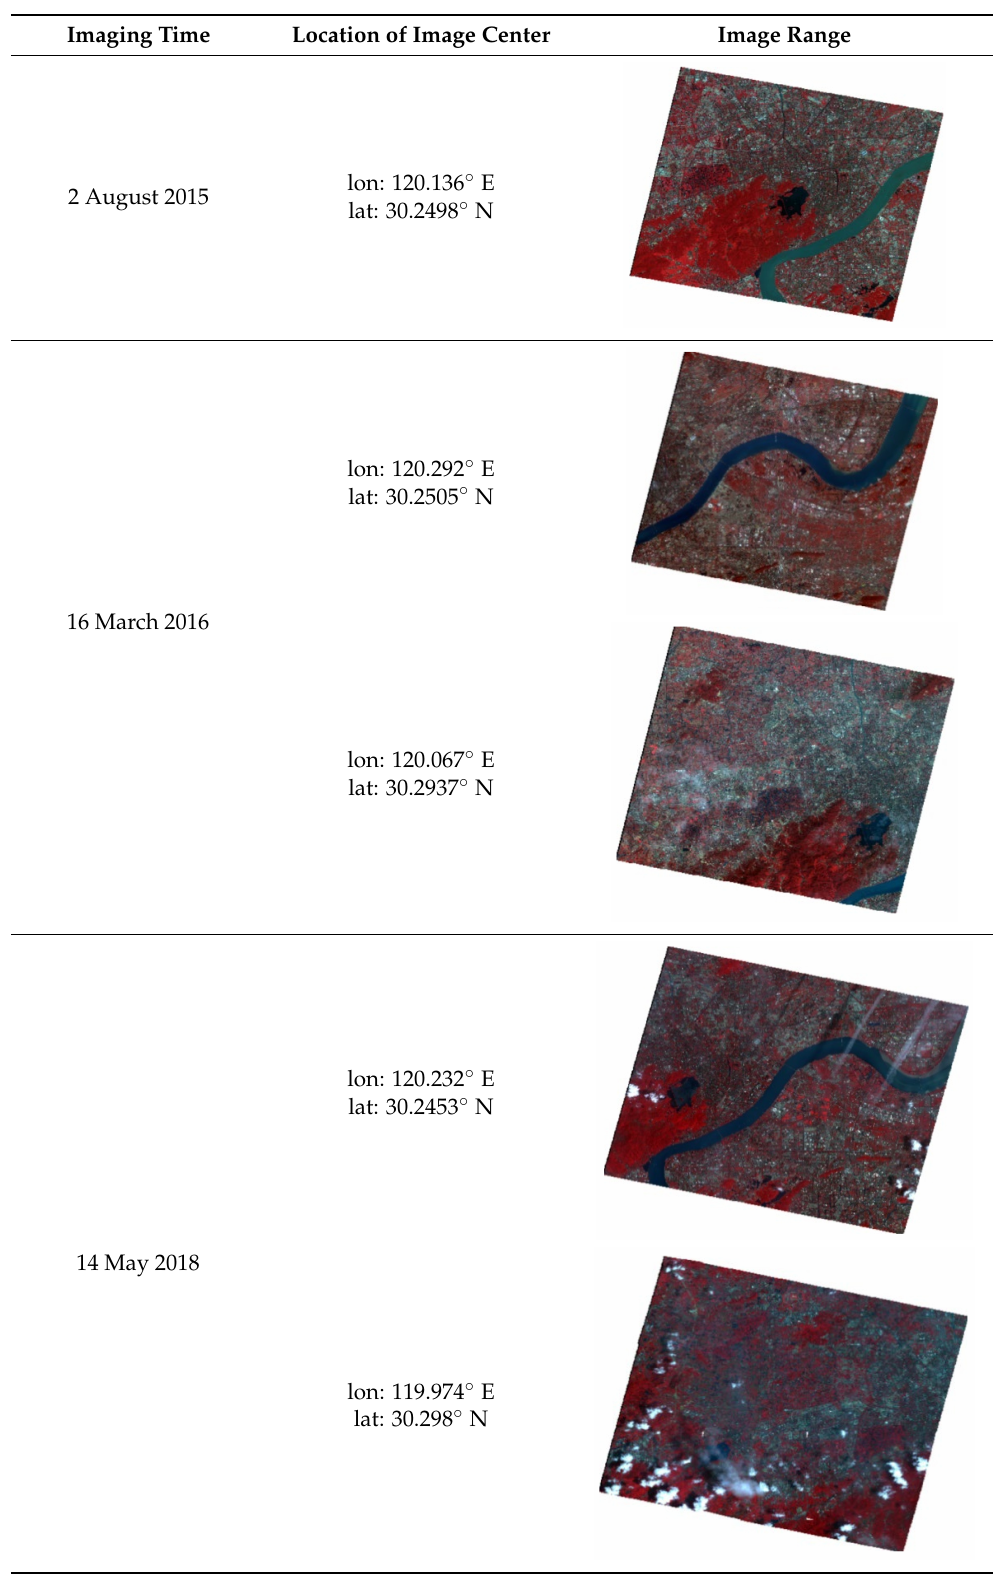
Table 2. Image information of the study